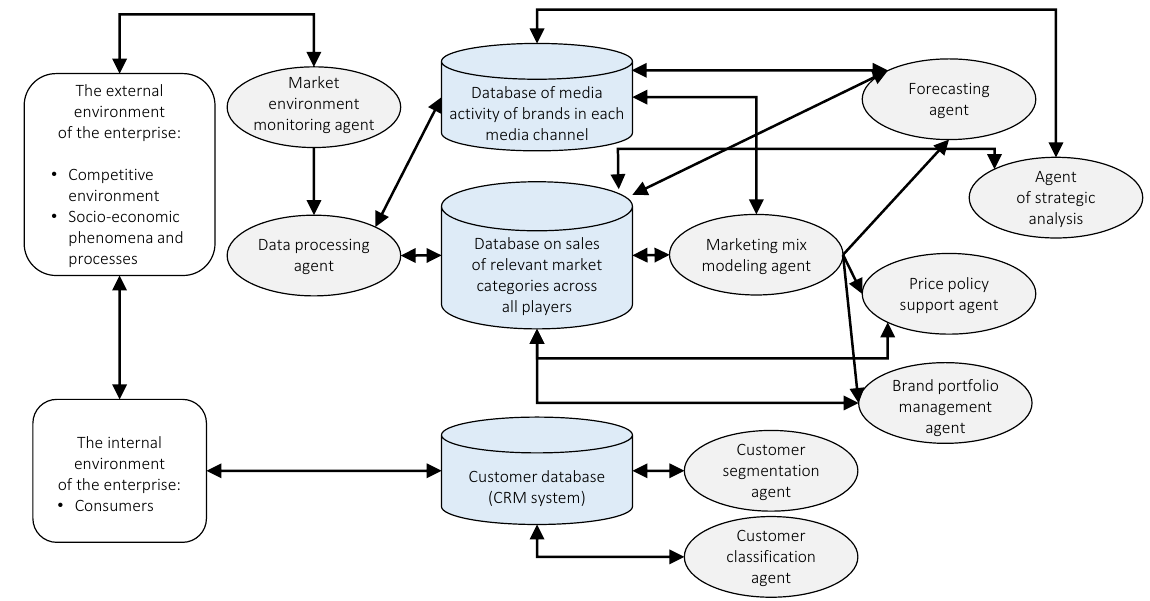
Figure 1. Architecture of the proposed multi-agent MDSS for brand